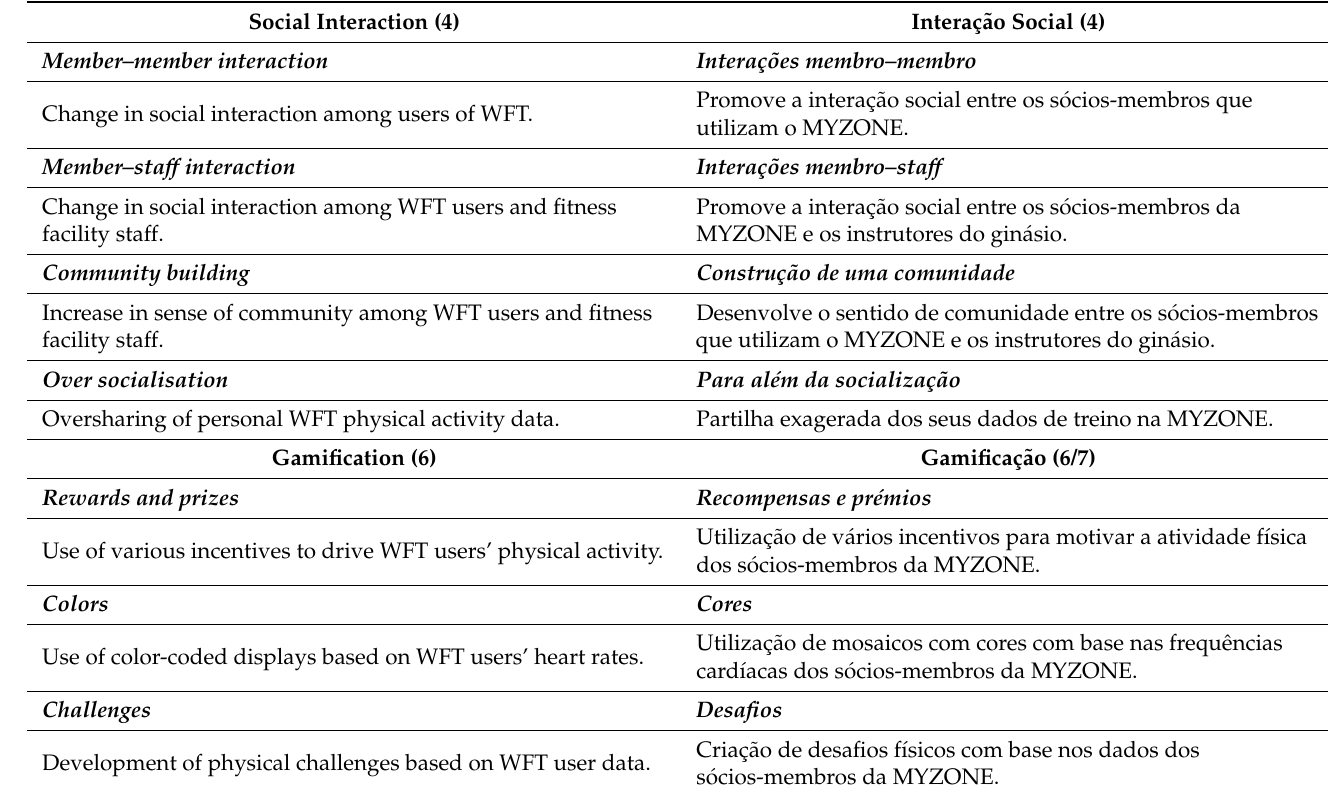
Table A1. The translation process of WFT